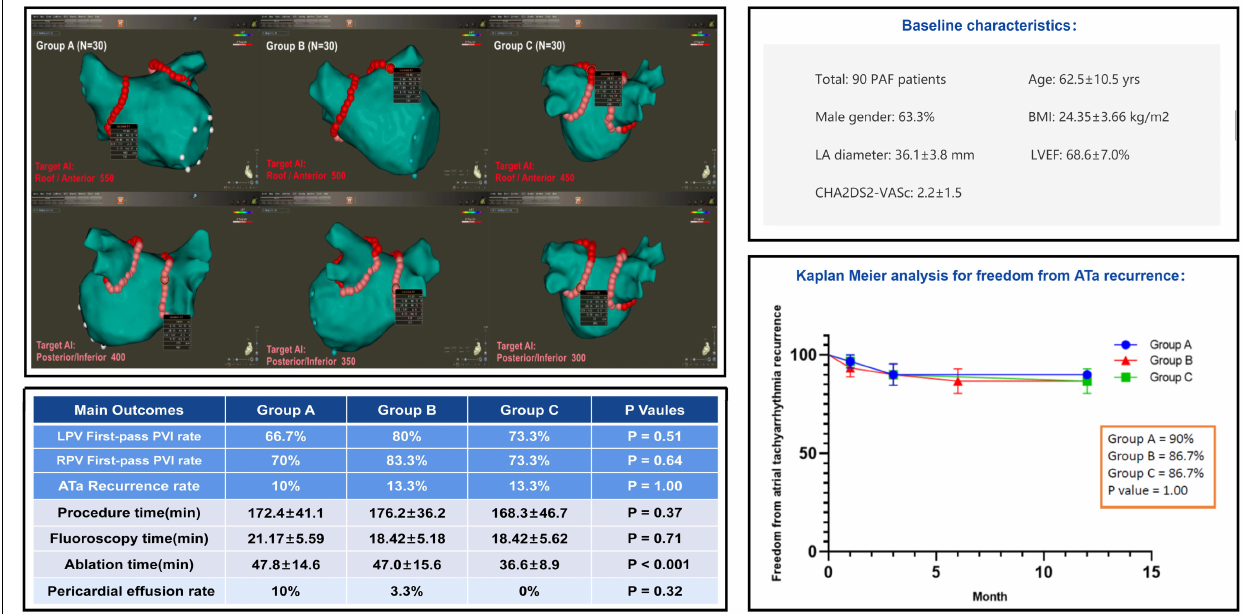
FIGURE 5 | Graphic